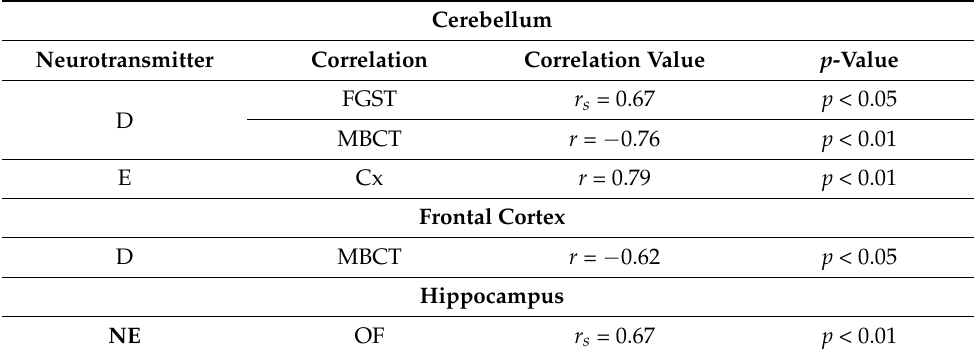
Table 1. Correlative analyses among parametrized variables in control